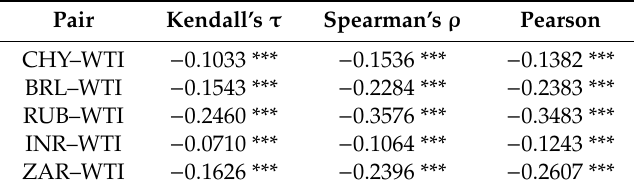
Table 5. Rank correlation and linear